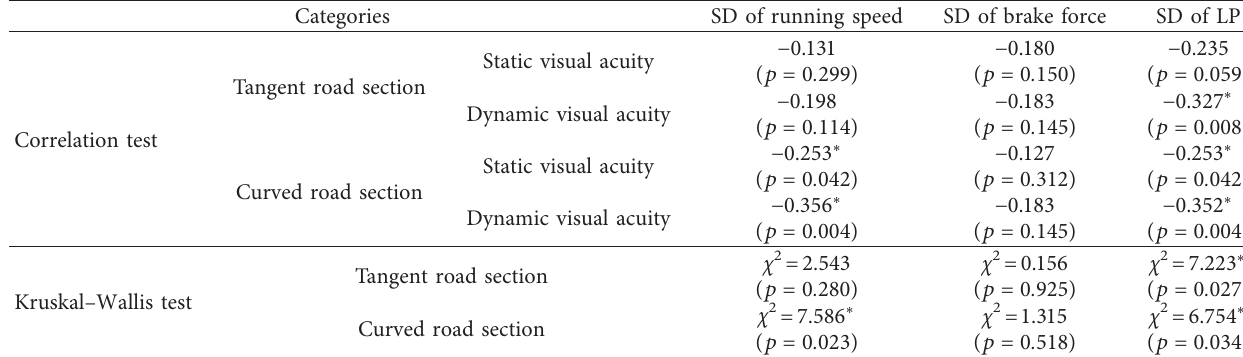
Figure 3: Comparison of driving behaviors according to visual acuity. Comparison of SD of (a) speed, (b) brake force, and (c) lateral placement according to visual acuity. Table 3: Correlation analyses and Kruskal–Wallis tests in scenario 1 (daytime).